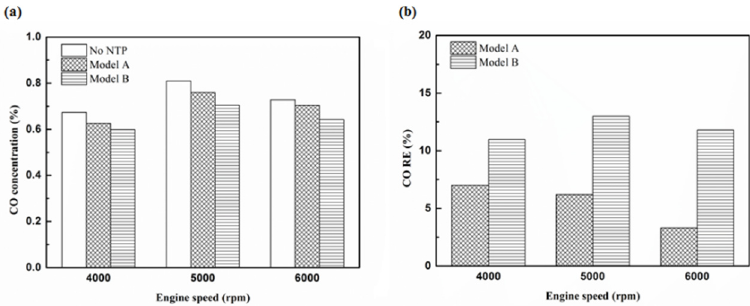
Figure 16. The CO ( a ) emission values and ( b ) RE of control voltage 5 V using platinum.